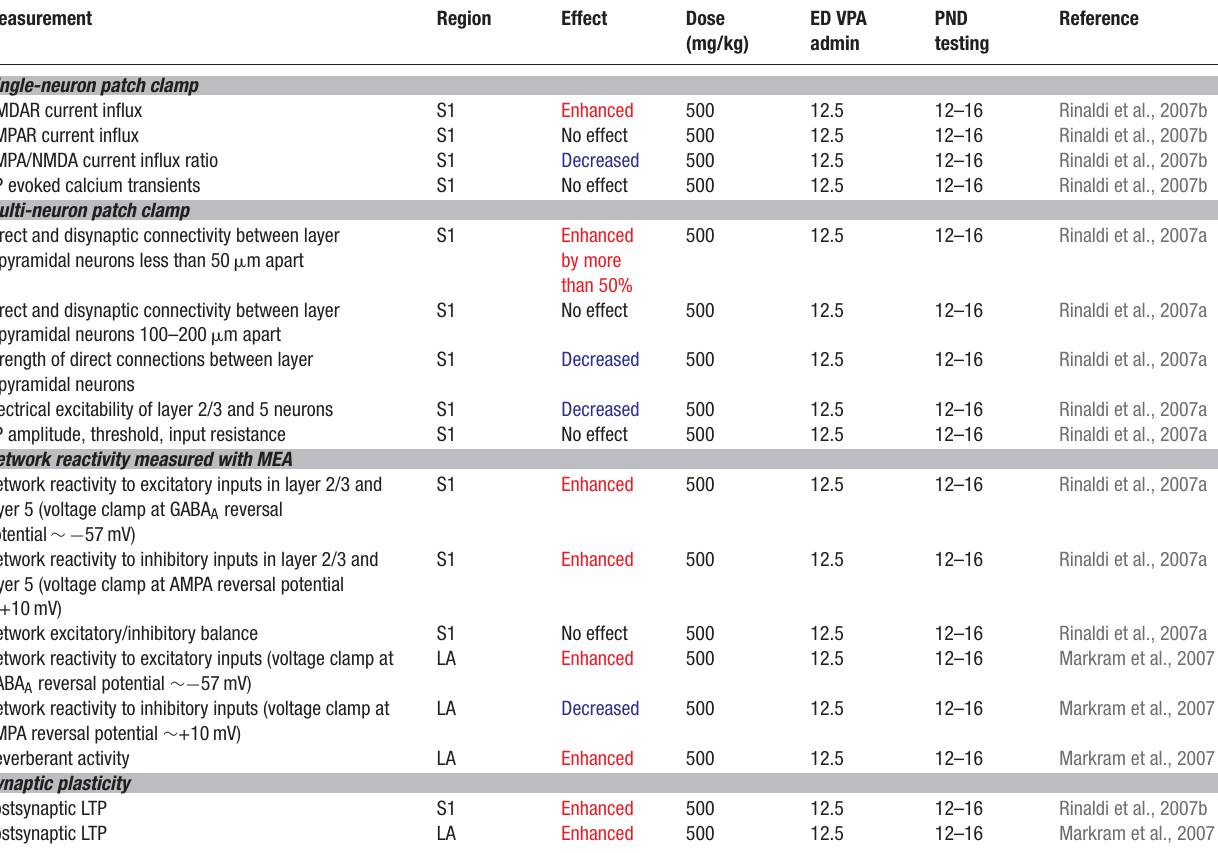
Table 5 . Microcircuit alterations in the VPA rat model of